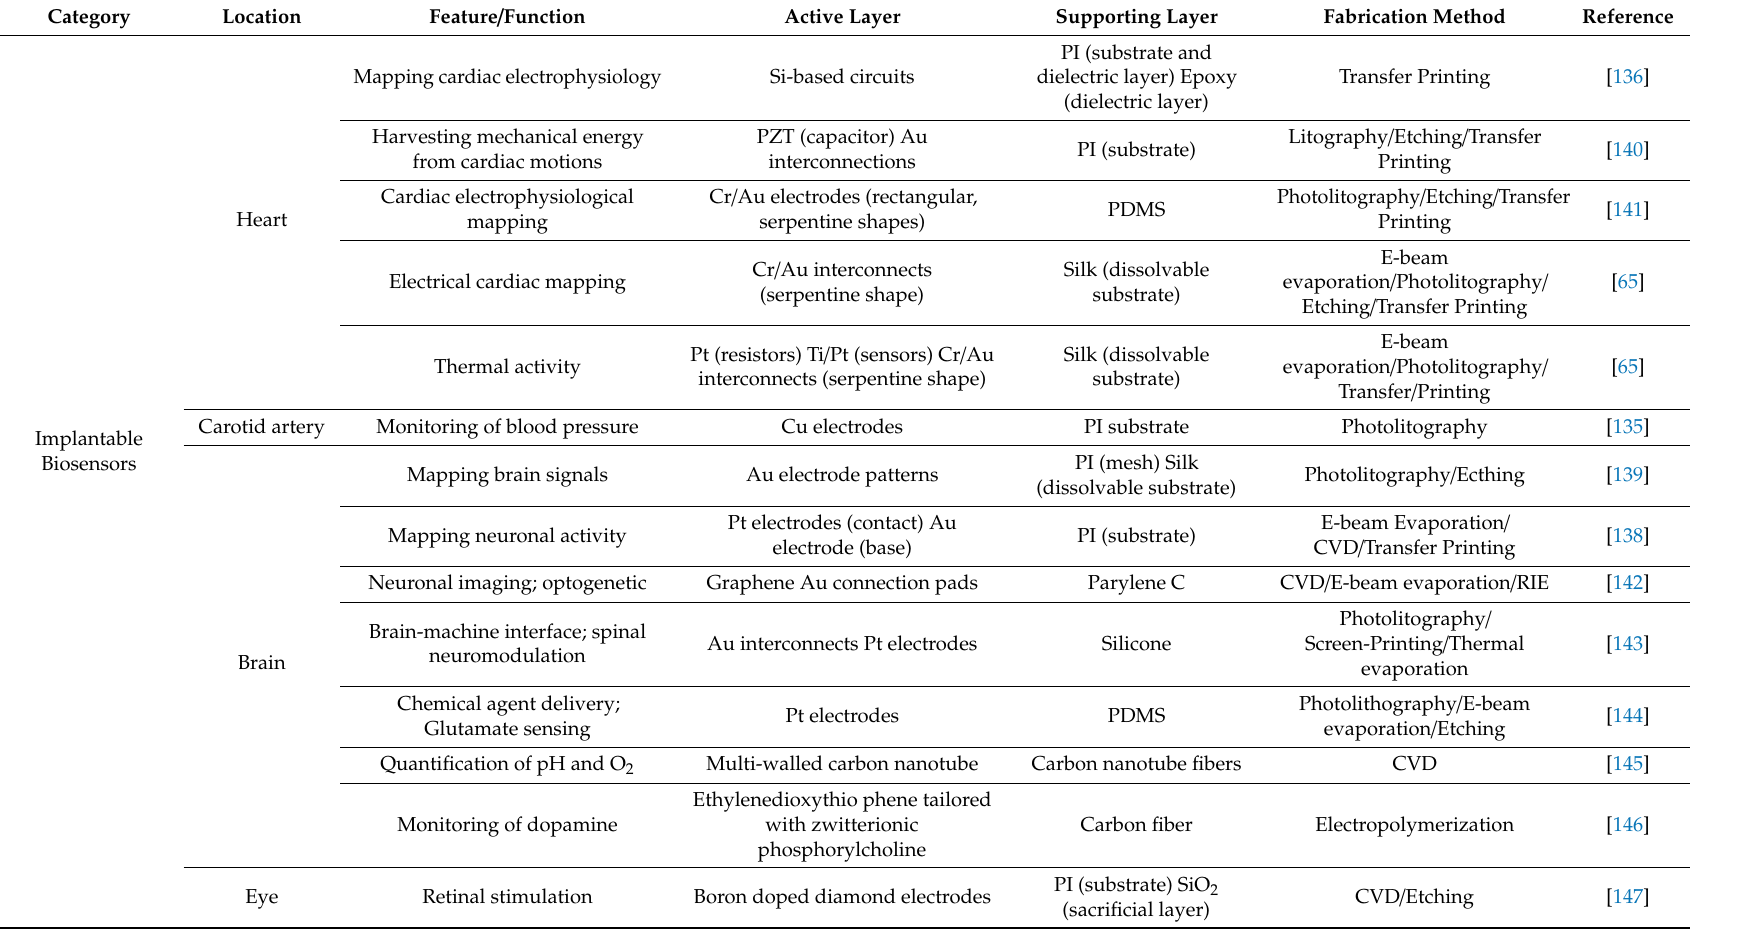
Table 1. Summary of applications and fabrication methods of implantable